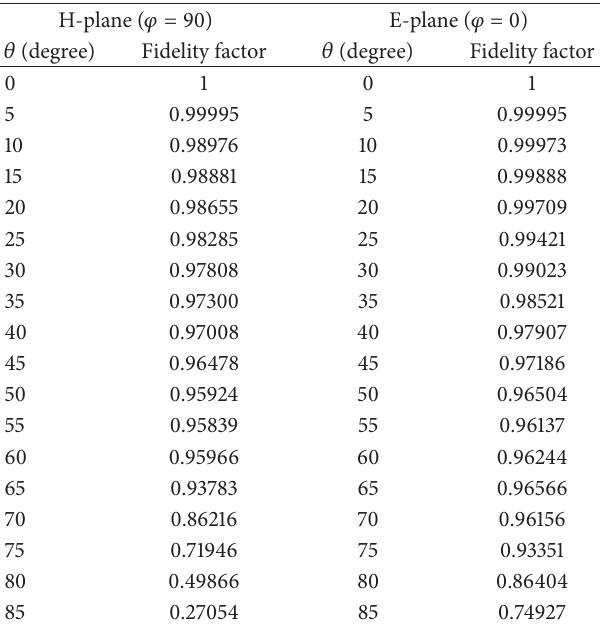
Table 4: Fidelity factor of the improved antenna computed in E- plane and